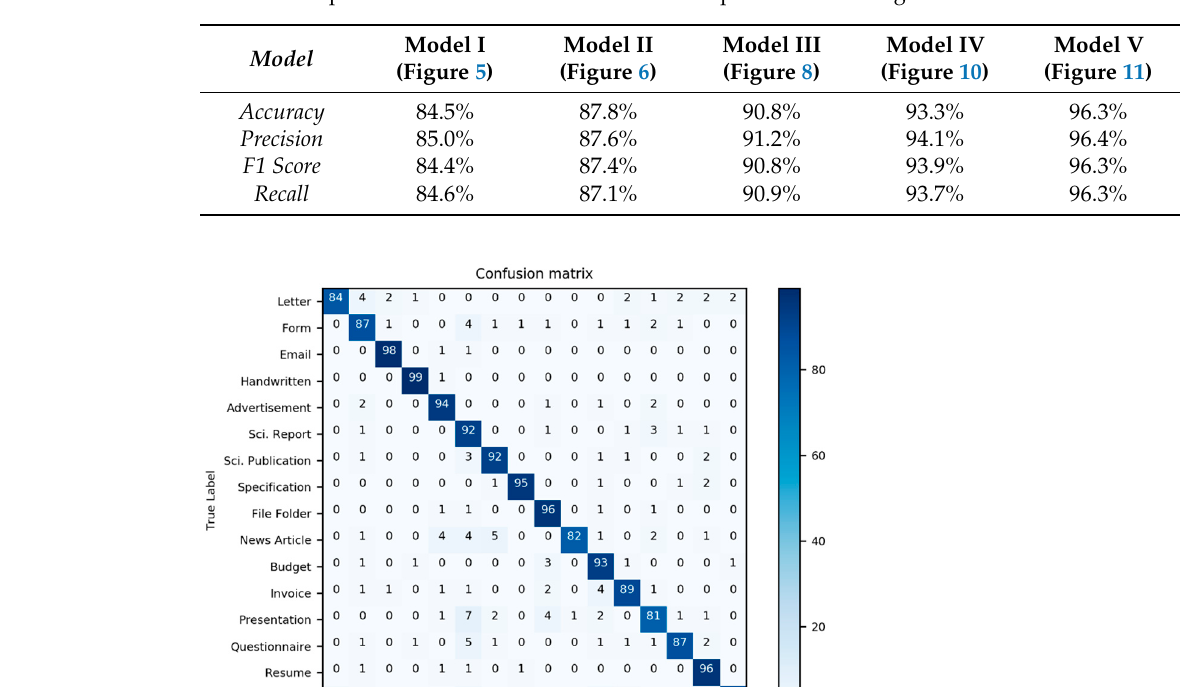
Table 2. Comparison of our novel model’s classification performance through different traditional metrics.